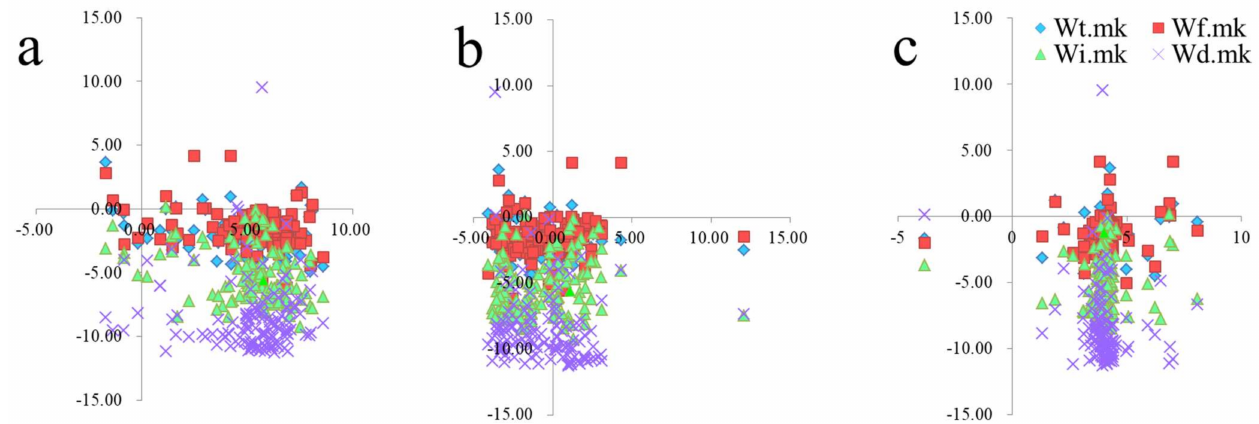
Figure 9. Correlation analysis between the trends in the WLN matching indexes and the trends in the tree-driving factors. ( a ), Correlation analysis between the trends in the WLN matching indexes and the trends in temperature; ( b ), Correlation analysis between the trends in the WLN matching indexes and the trends in precipitation; ( c ), Correlation analysis between the trends in the WLN matching indexes and the trends in